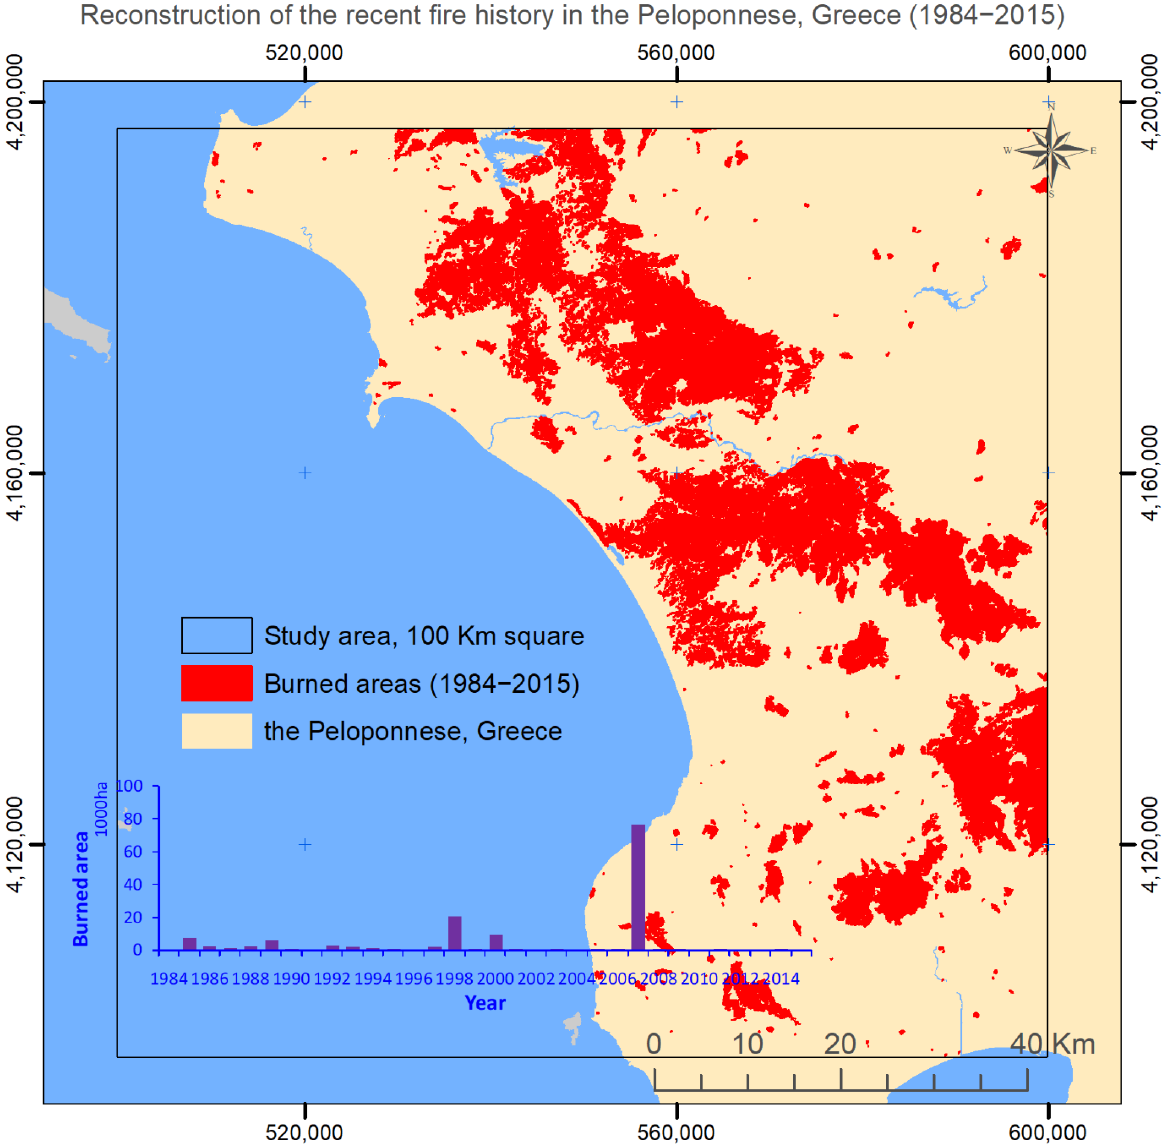
Figure 6. Spatially explicit reconstruction of the recent fire history using Landsat images and the rule-based approach [15], as also modified and improved by Koutsias and Pleniou [42].